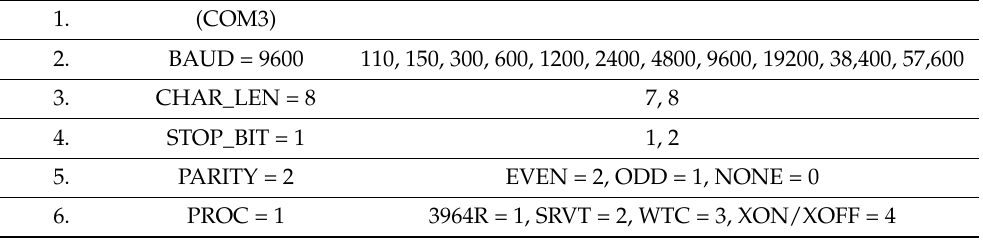
Figure 3. The setting of serial interface communication.